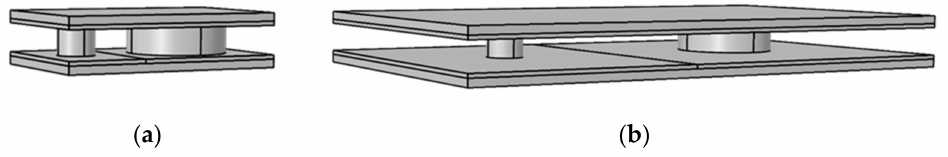
Figure 4. TE pairs with different connector dimensions more suitable for a lower ( a ) or higher ( b ) thermal resistance of the heat